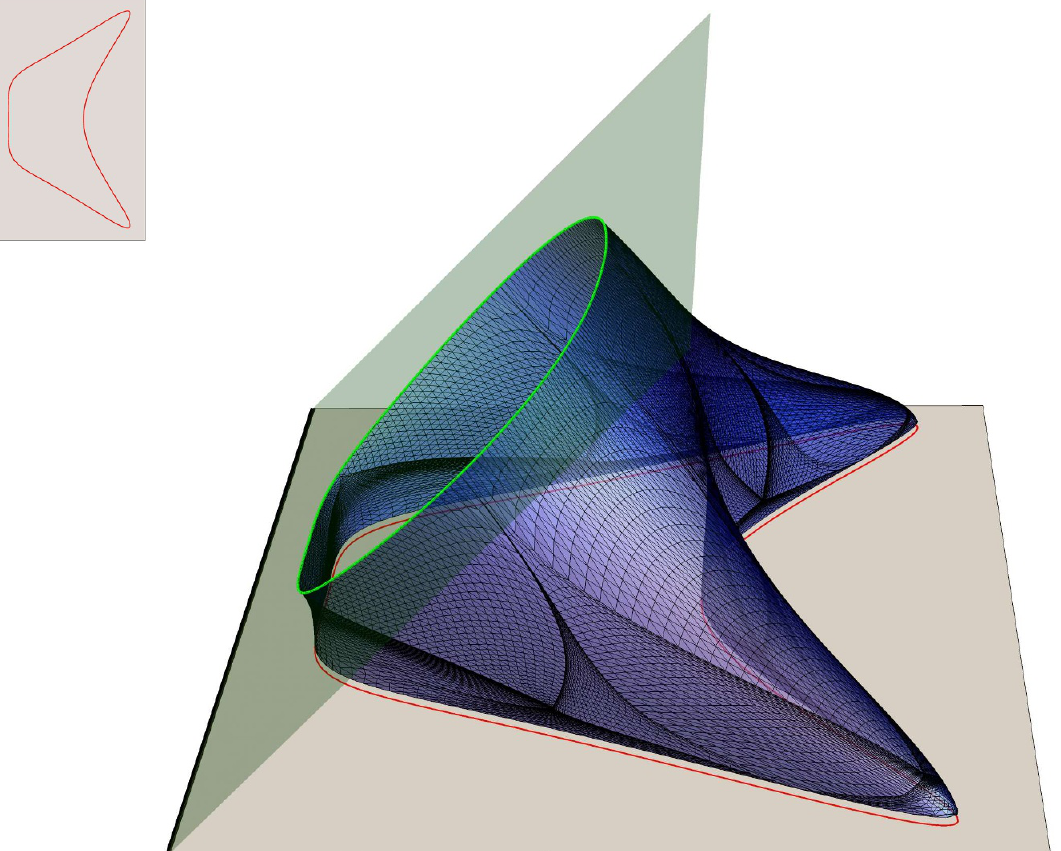
Figure 1 . Extremal surface ^ (cid:13) " constructed with Surface Evolver from a spatial domain A in the right half plane (the grey half plane) whose @A is the red curve, which is also highlighted in the inset. The gravitational bulk is the part of H 3 de(cid:12)ned by (2.21), whose boundary is made by the conformal boundary at z = 0 (the grey half plane) and Q (the green half plane de(cid:12)ned in (2.20)). Here (cid:11) = 3 (cid:25)= 4. The green curve corresponds to @ ^ (cid:13) Q = ^ (cid:13) " \ Q , and ^ (cid:13) " intersects Q orthogonally along this